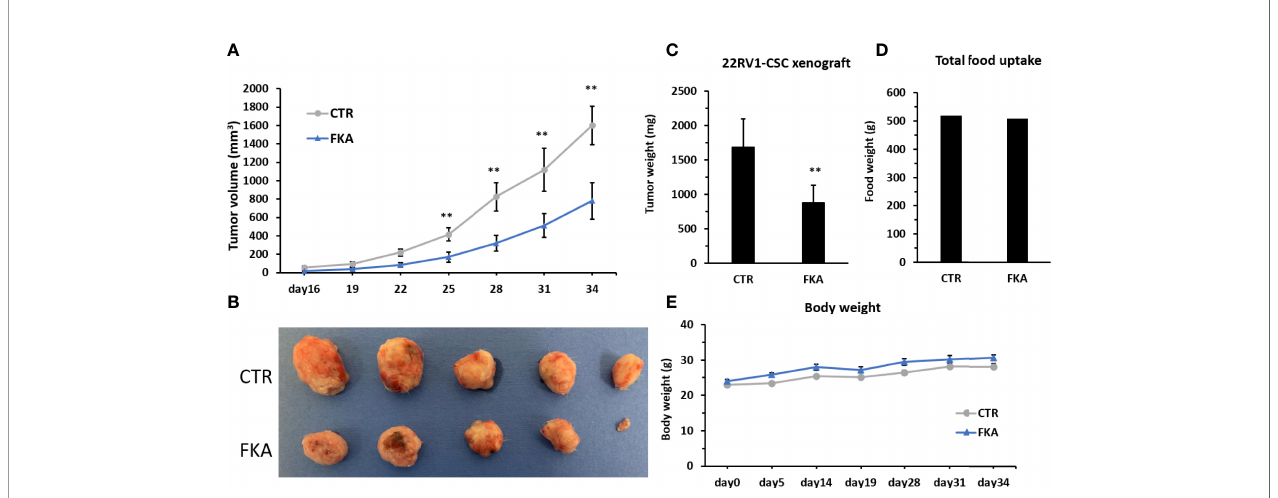
FIGURE 3 | Dietary FKA inhibit prostate CSC – initiated tumor growth. (A) Mice were each subcutaneously injected with ten thousand of sorted CD133 and CD44 double-positive 22Rv cells and randomized into the vehicle control (CTR) diet and 0.6% FKA-formulated diet. Tumor volumes were measured every 3 days and means ± standard errors (SEM) are shown. (B) Photographs of each tumor at the end of treatment. (C) Tumor weights from both groups were measured and analyzed at the end of the treatments. (D) Food uptake was measured every 3 days, and the total weights of food are shown in CTR and FKA groups. (E) Body weights of mice were recorded over time, and the mean body weights of each group are shown. Error bars represent SEMs (n = 5). **: